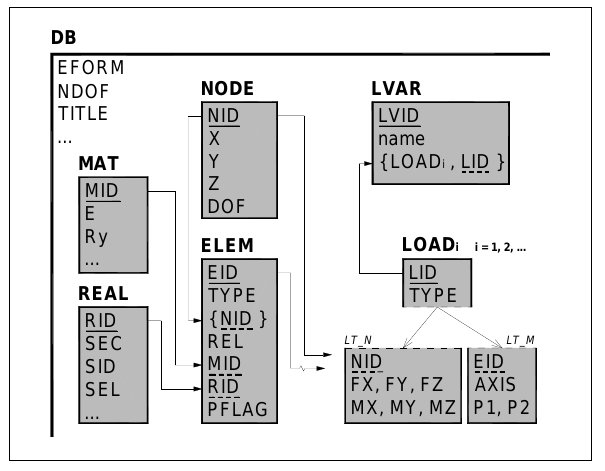
Fig. 14. SAOSYS database DB of structural model